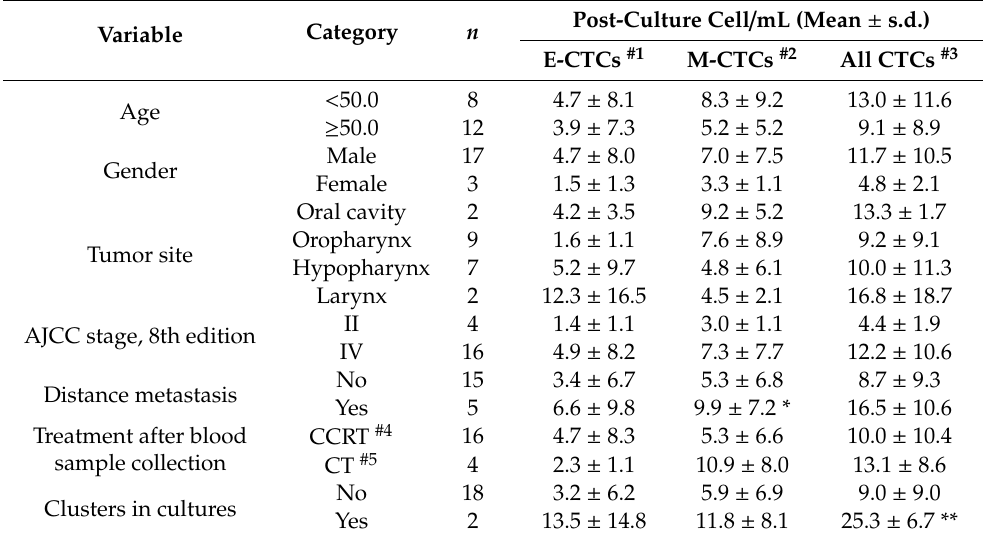
Table 2. Number of CTCs according to the variable